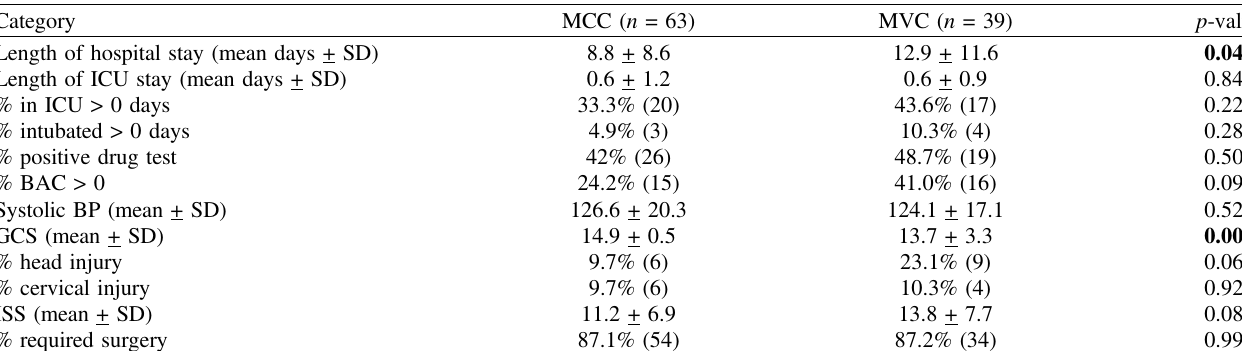
Table 4. Patient clinical